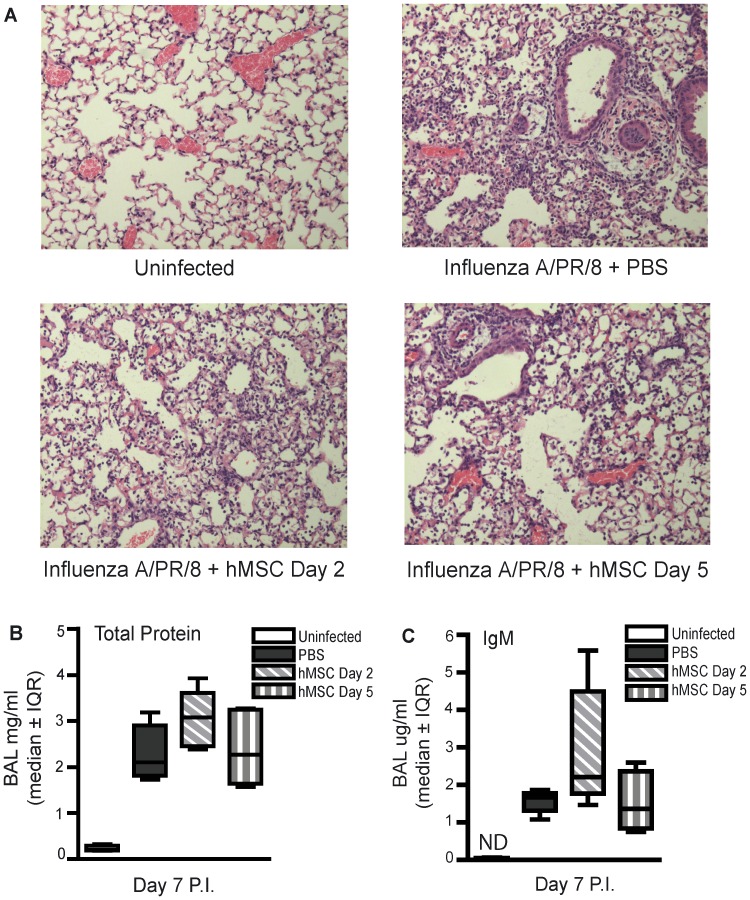
Therapeutic administration of hMSCs failed to modify pulmonary inflammation or alter acute lung injury in experimental severe influenza.Eight week old male C57Bl/6 mice were infected with 425 EID50 influenza A/PR/8 virus and administered 5×105 hMSCs (passage 3) on day 2 or day 5 P.I. Mice were sacrificed and BAL was performed on day 7 P.I. (A) Representative images of hematoxylin and eosin stained lung sections demonstrate similar cellularity and lung injury in hMSC treated mice compared to infected controls. (B,C) No significant difference in markers of ALI (total protein or IgM) was observed between mice administered hMSCs on day 2 or day 5 P.I. and infected control mice administered PBS (one-way ANOVA, n = 5/group, representative of 2 independent experiments). Error bars represent interquartile range (IQR). ND = nondetectable.